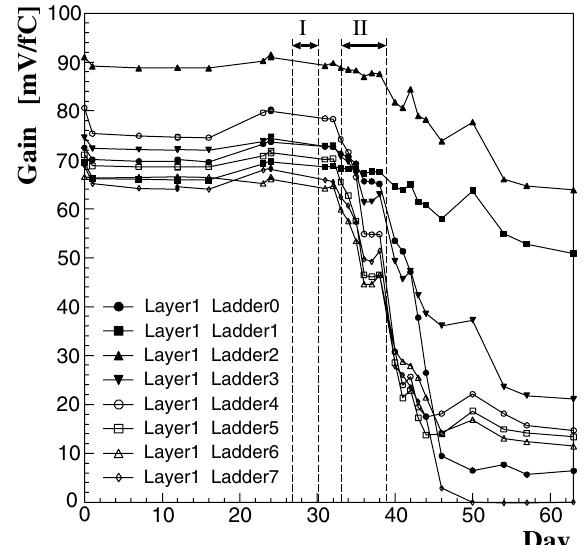
FIG. 5. SVD gain as a function of time around the SVD gain- drop accident, together with the two periods used in the bench- mark test. The ladder numbers in this figure correspond to the position numbers in Tables I and II, and Fig. 7. The gain-drop plots are extracted from